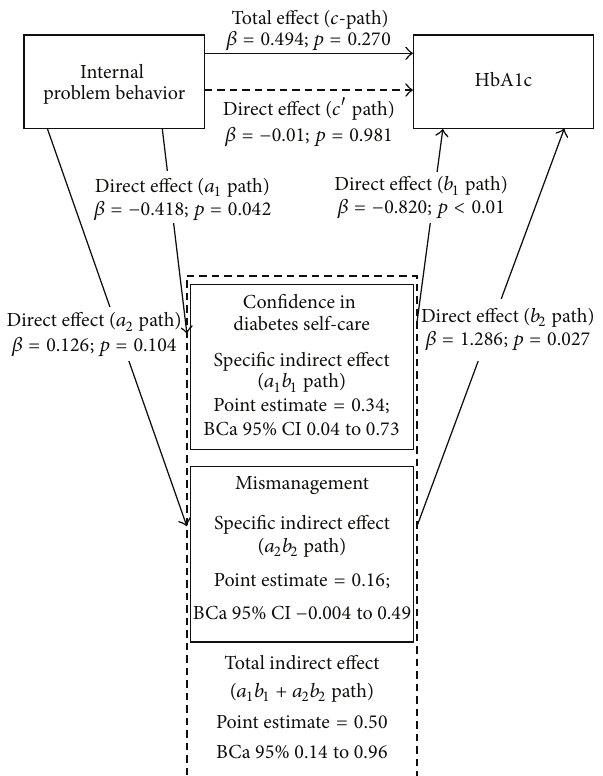
Figure 3: Graphic representation of the multiple mediation model of the associations between internal problem behavior and glycemic control. 5000 resamples were calculated while using the bootstrap method